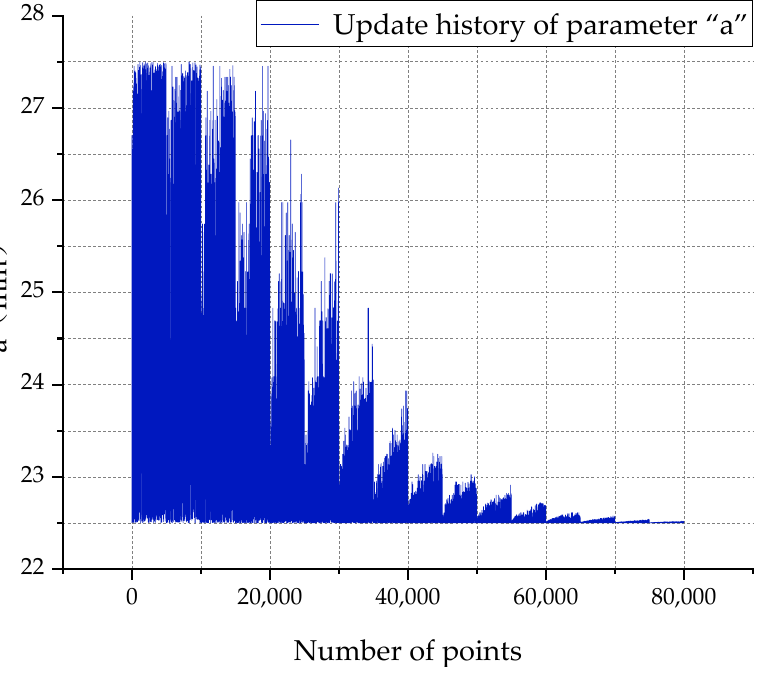
Figure 21. The iterative process of parameter “b”.